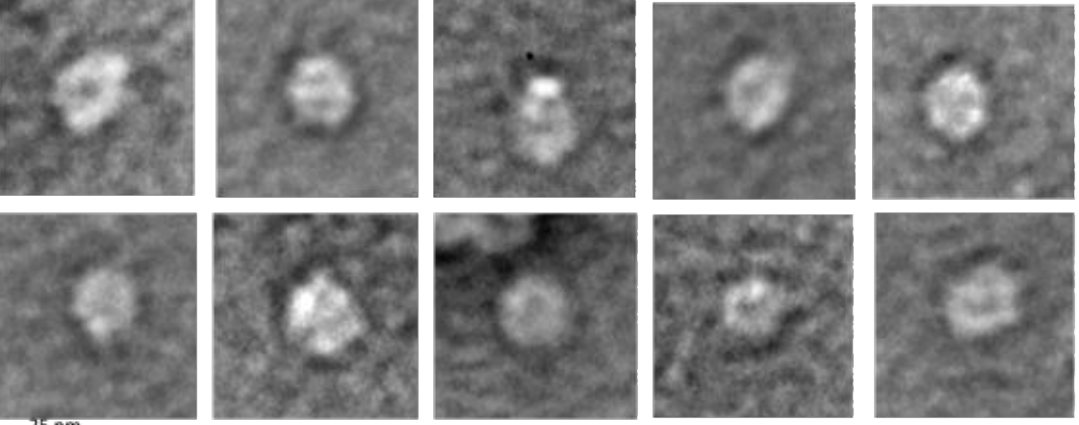
Figure 8. Electron micrographs of G1p/G11p complexes. The purified G1p/G11p was applied to a 400-mesh grid, negatively stained with UAc and analysed by electron microscopy. Note the white dots that appear in some of the complexes. dots that appear in some of the